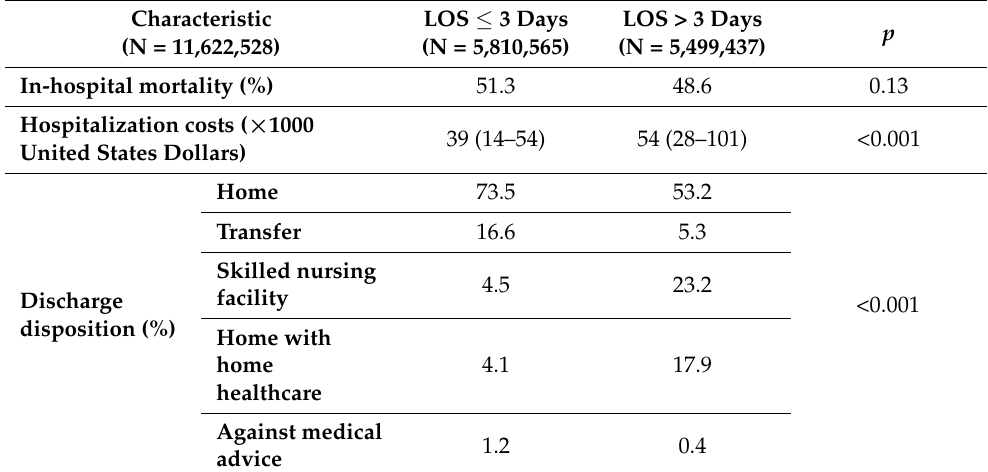
Table 3. Clinical outcomes of AMI admissions with LOS ≤ 3 days and LOS > 3